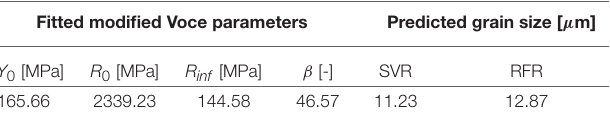
TABLE 3 | Summary of fitted modified Voce parameters from microstructure model with the average grain size of µ =15.0 µ m and σ =0.1 and predicted grain size using trained ML